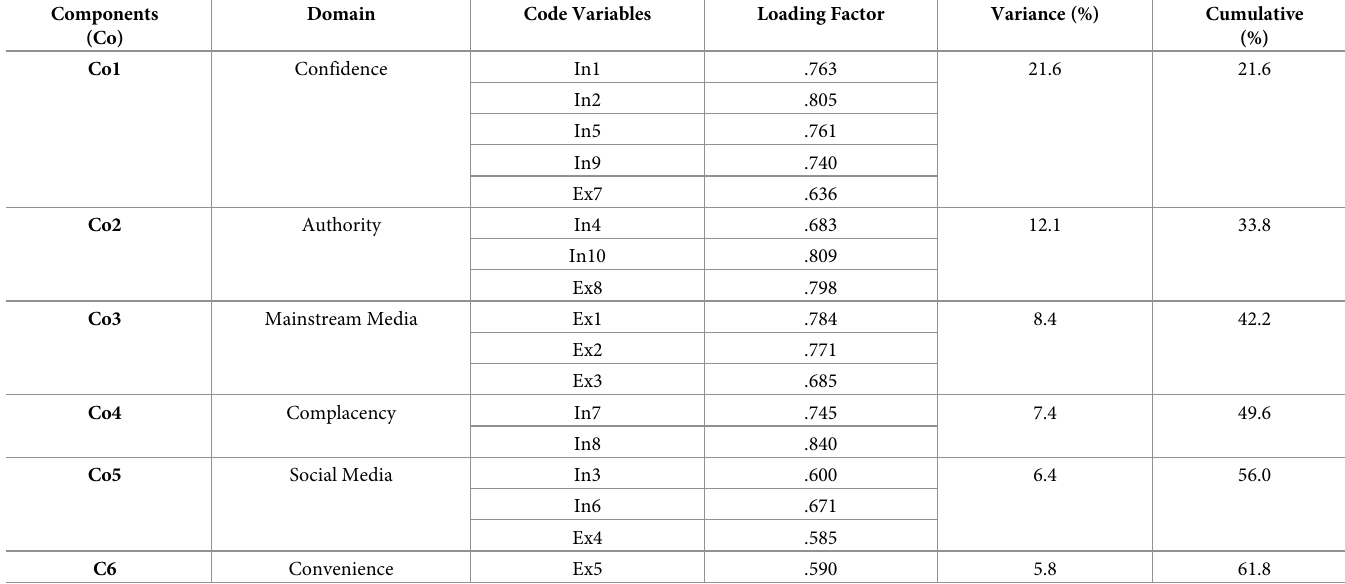
Table 7. Analysis results of Cluster 2 PCA.